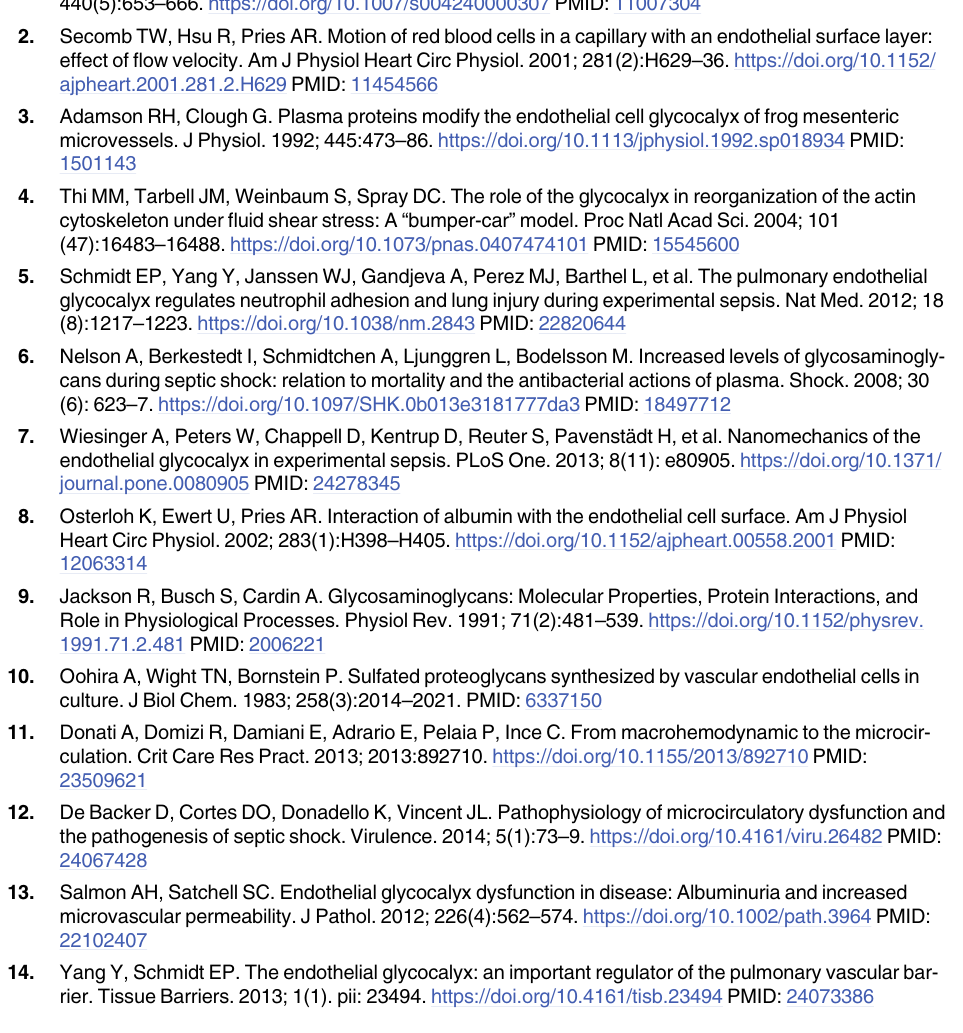
S1 Table. Gene expression profiling of each of the sorted cells using